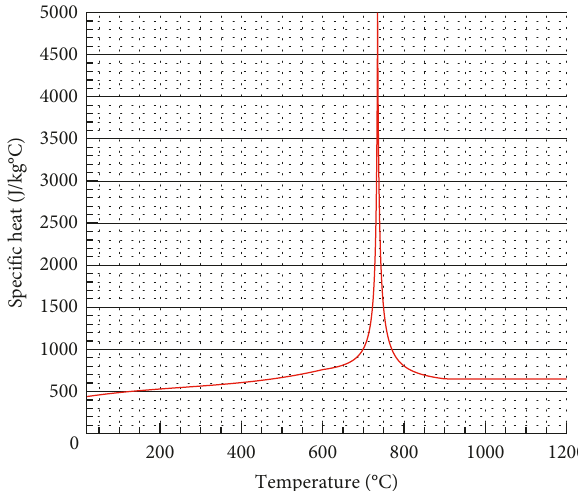
Figure 10: Specific heat for steel at elevated temperatures (BS EN